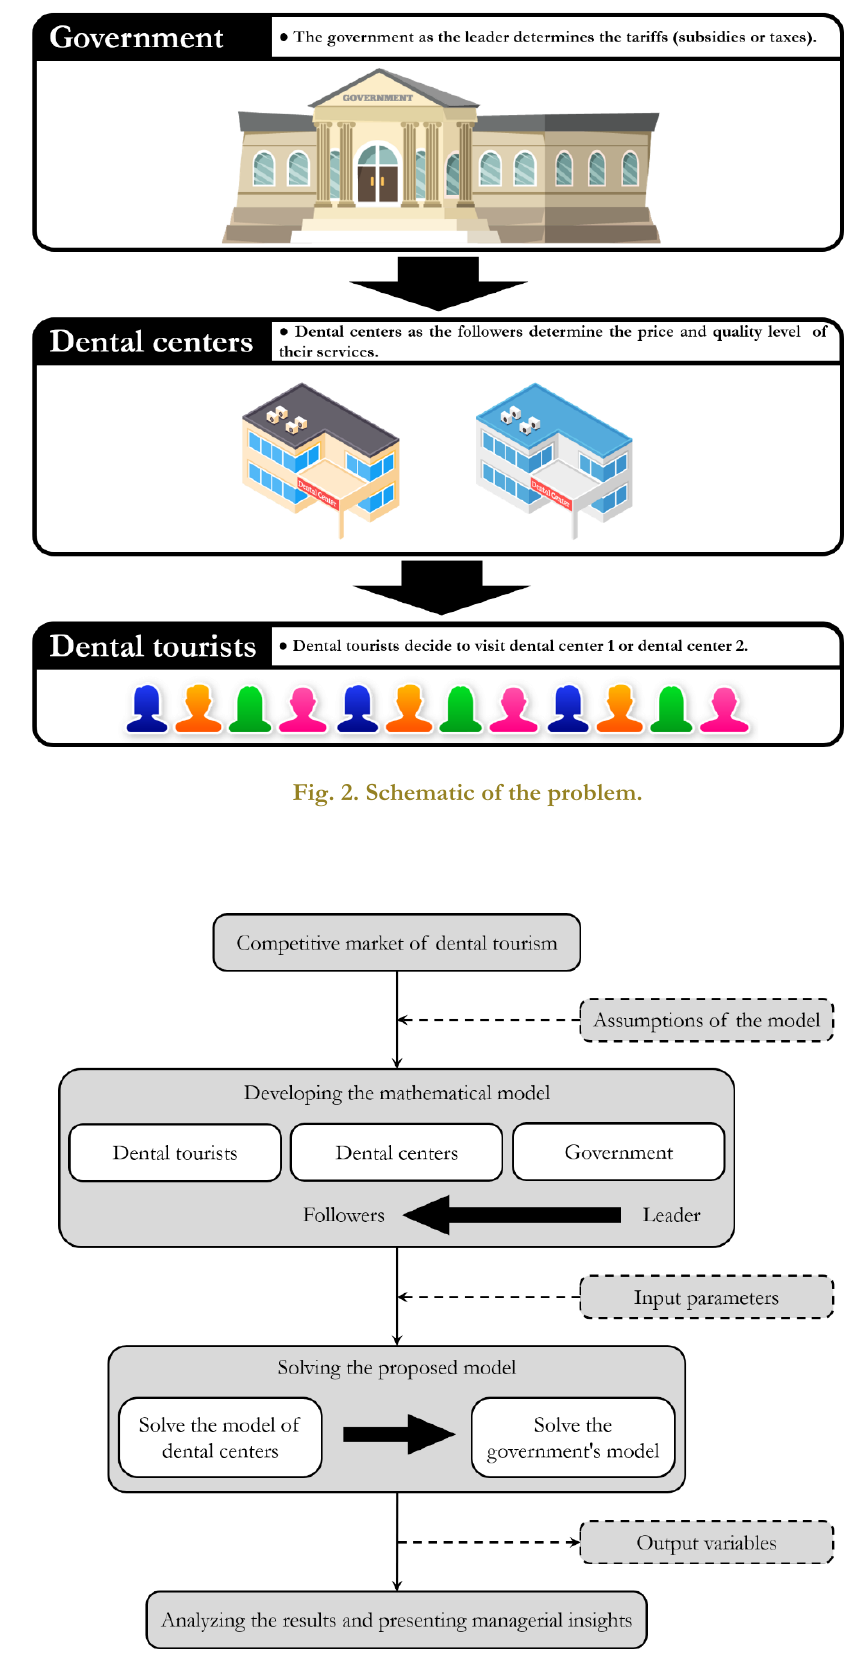
Fig. 3. The research flowchart of this